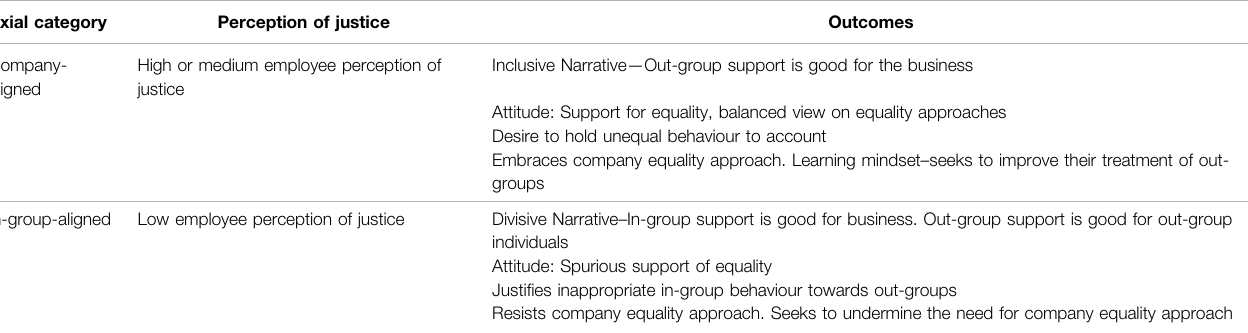
TABLE 10 | Outcomes of in-group and company